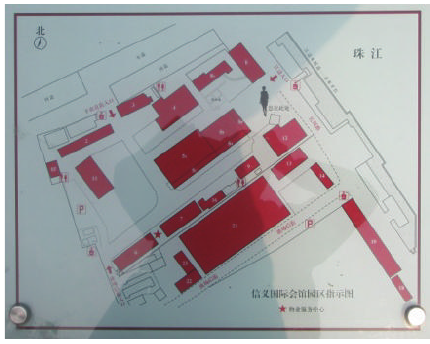
Figure 2: Layout of Xinyi Place.